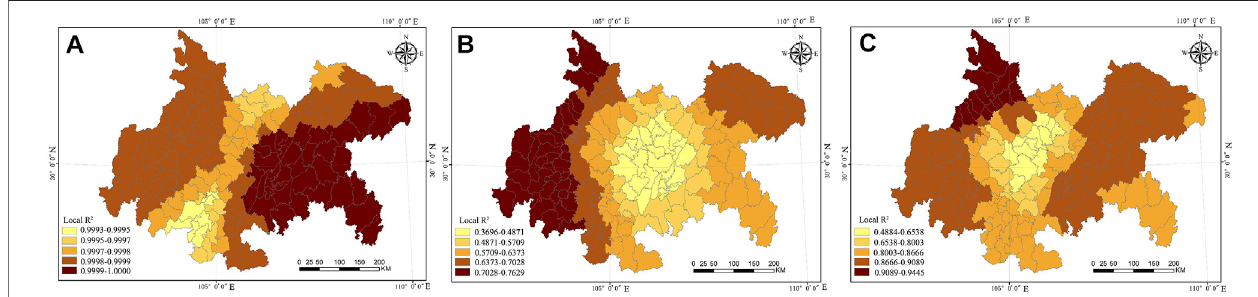
FIGURE 5 | Spatial heterogeneity distribution of ES under different factors (A) . WY; (B) CS; and (C) SC.